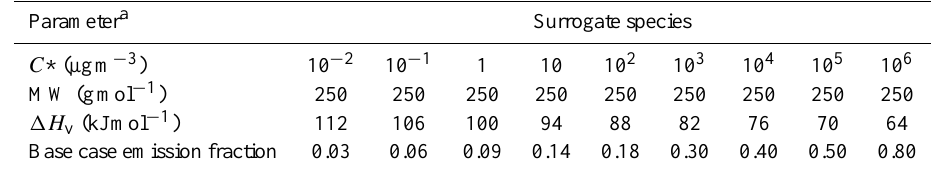
Table 3. Parameters used to simulate partitioning of primary organic aerosol in PMCAMx and EMEP MSC-W. Parameter a Surrogate